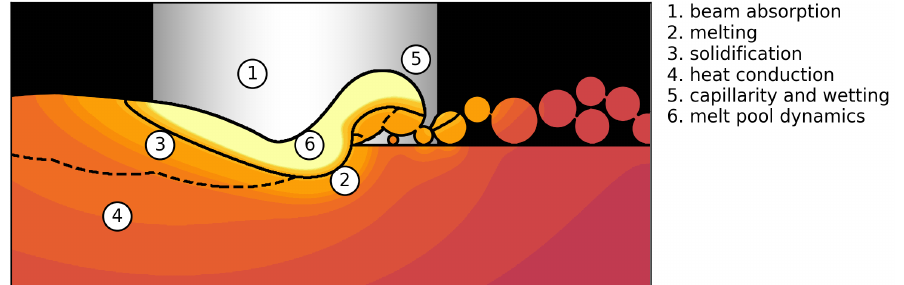
Figure 1. Physical phenomena involved in a powder bed fusion additive manufacturing process. The figure depicts an example simulation plane with beam movement out of the plane. Melt pool and already solidified material are indicated. The colored temperature field is shown